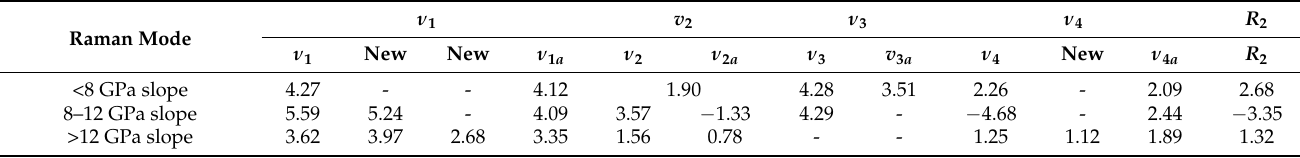
Table 2. The variations in the slope ( d ν / dP , cm − 1 /GPa) of each Raman mode in scottyite. Raman Mode